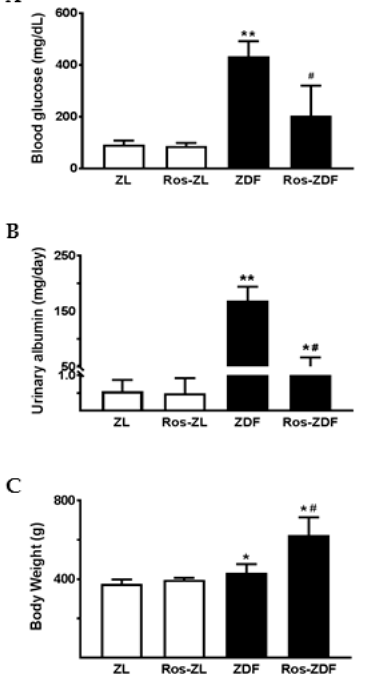
Figure 3. Effect of rosiglitazone on blood glucose, urinary albumin, and body weight in Zucker rats. Rosiglitazone reduced blood glucose ( A ) and urinary albumin ( B ) levels but increased body weight ( C ) in ZDF rats. Values are mean ± SEM. n = 4–7 rats; * p < 0.05 and ** p < 0.01 compared with their ZL controls (ZDF vs. ZL or Ros-ZDF vs. Ros-ZL); # p < 0.05 compared to vehicle-treated ZDF group (Ros-ZDF vs.